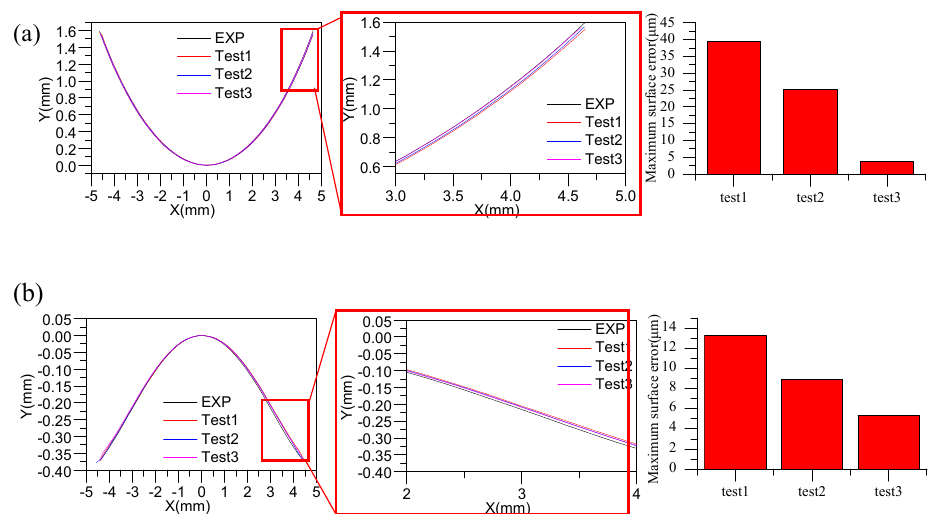
Figure 13. The simulation model of glass aspheric lens molding.